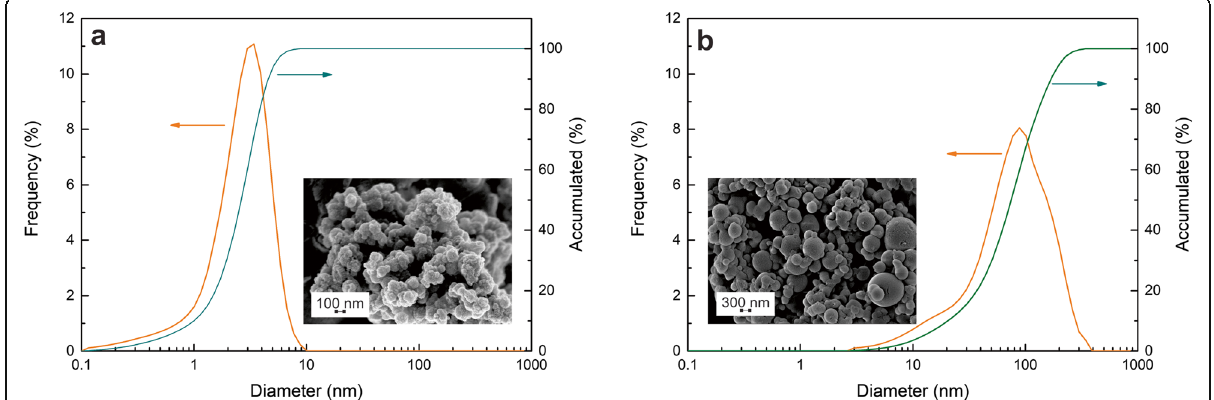
Fig. 1 Particles size distribution and SEM micrographs of: a ) Cu and b ) Si-Cu